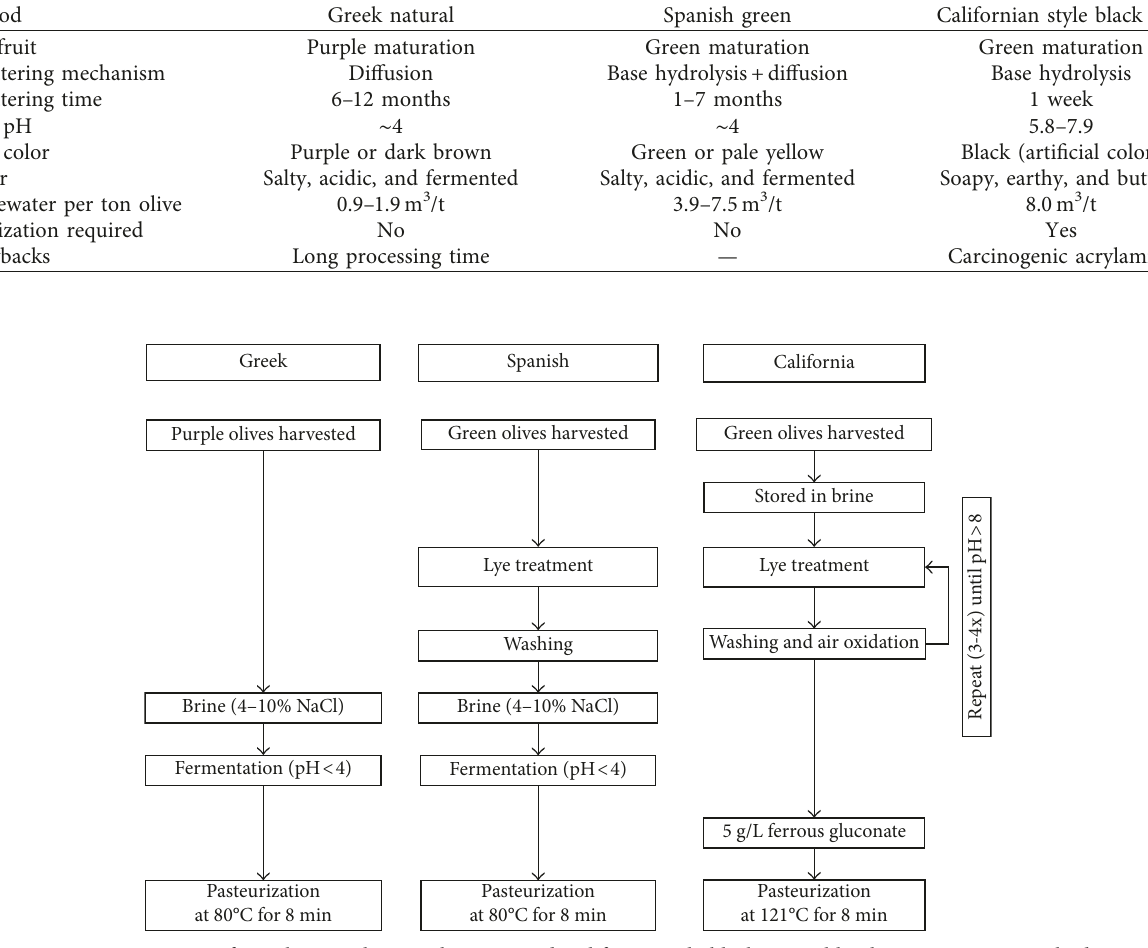
Table 1: Comparison of Greek natural, Spanish green, and California style black ripe table olives processing parameters.